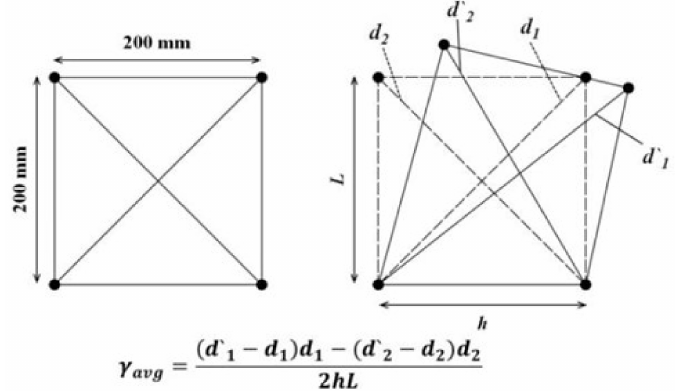
Figure 6. Shear deformation of steel fiber-reinforced concrete beam specimens.